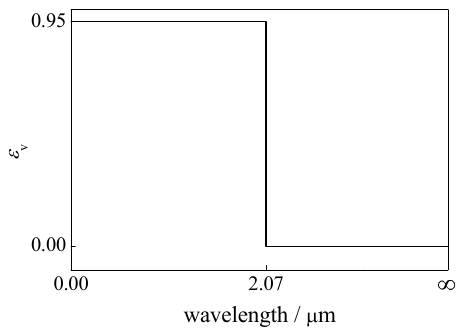
Figure 2. Schematic of the spectral emissivity of the photovoltaic (PV) cell coating. Table 1. Optical properties of the components of the thermophotovoltaic (TPV) system. Component Emissivity Reflection Type Emitter 1 Fully diffuse PV cell Selective, see Figure 2 Fully diffuse Mirror 0.1 Mostly specular, specular fraction 0.95